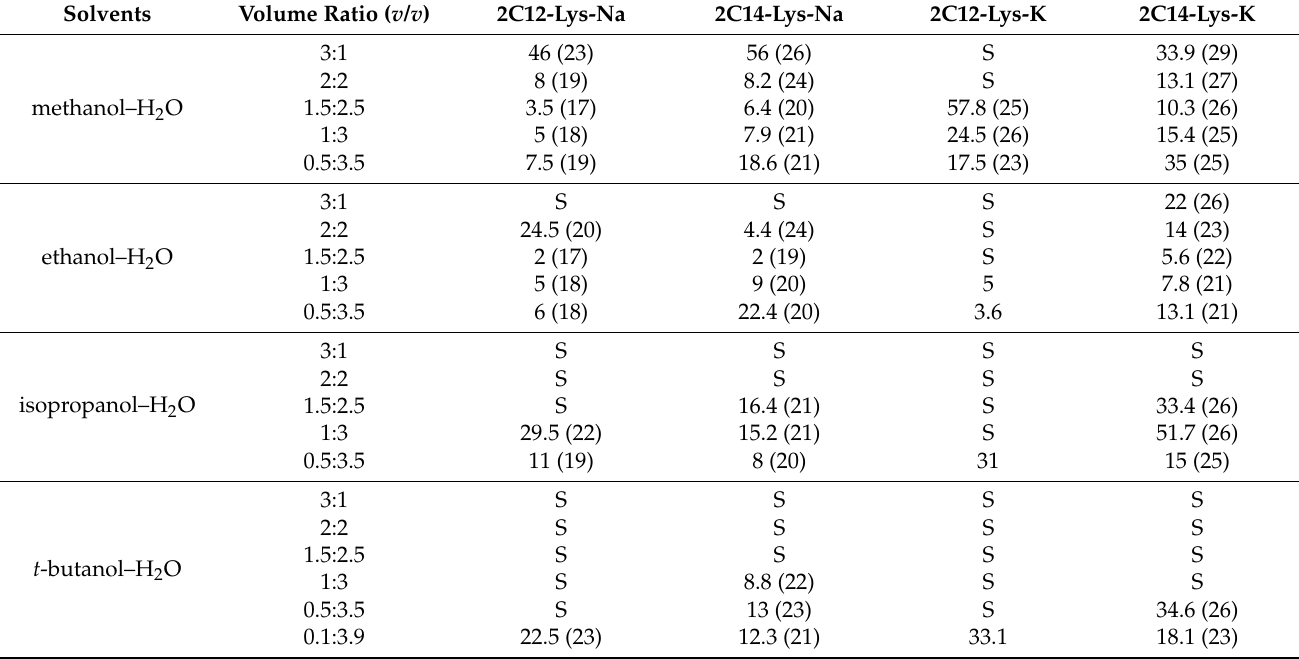
Table 1. Gelation behaviors of 2C12-Lys-Na, 2C12-Lys-K, 2C14-Lys-Na, and 2C14-Lys-K in alcohol– water mixtures with different volume ratios ( v / v